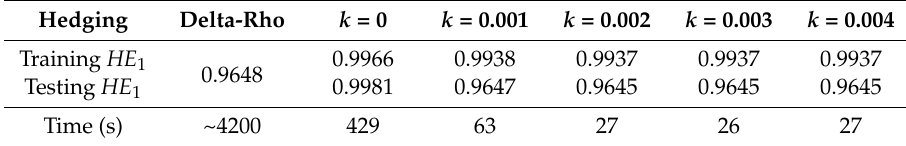
Table 5. Hedging metrics for different hedging strategies and error functions for guaranteed minimum income benefit (GMIB).